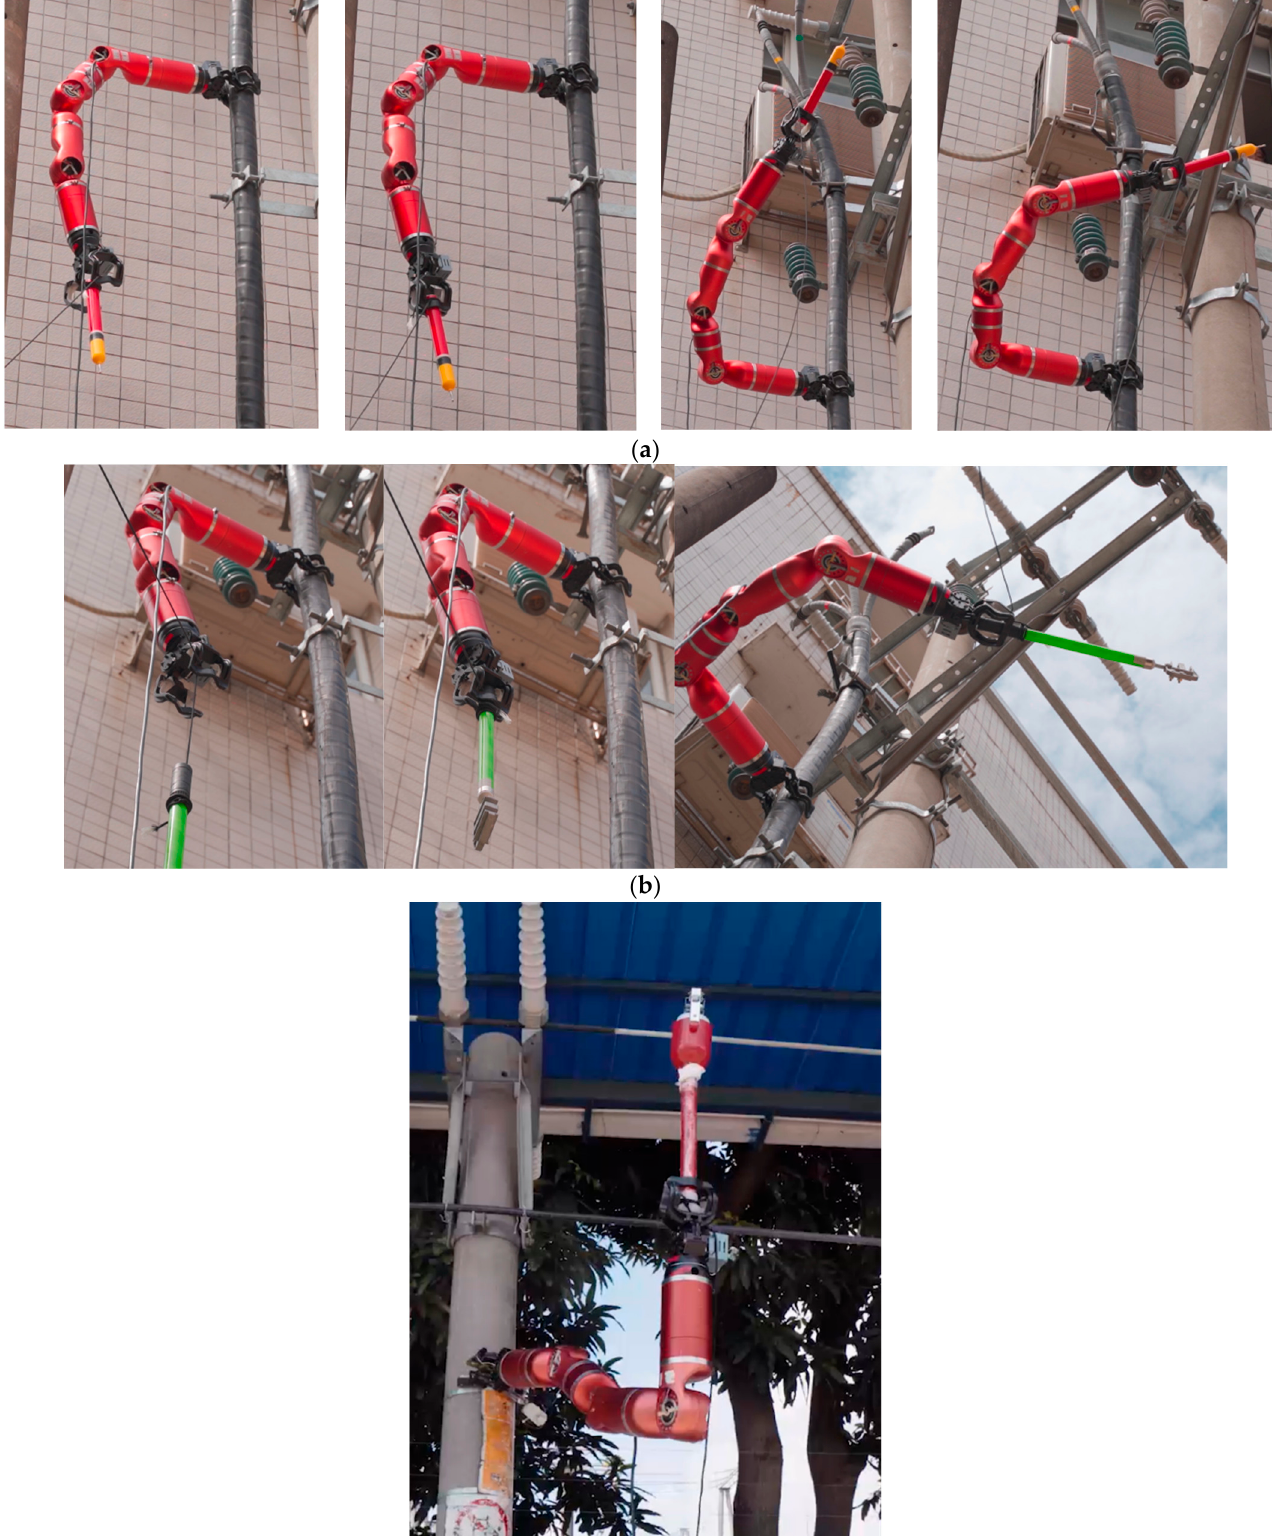
Figure 30. Simulation of several live working projects. ( a ) Verification of live part, ( b ) grounding, ( c ) installing fault